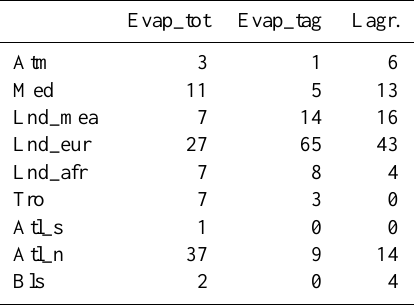
Table 1. Relative contributions of the different moisture sources to the precipitation in the target region between 00:00UTC on 15 May and 00:00UTC on 18 May 2010 (in %). The first column shows re- sults from the COSMO tagging simulation with parameterisation Evap_tot, the second column from the simulation with parameteri- sation Evap_tag and the third column from the Lagrangian diagnos- tics. Evap_tot Evap_tag Lagr.